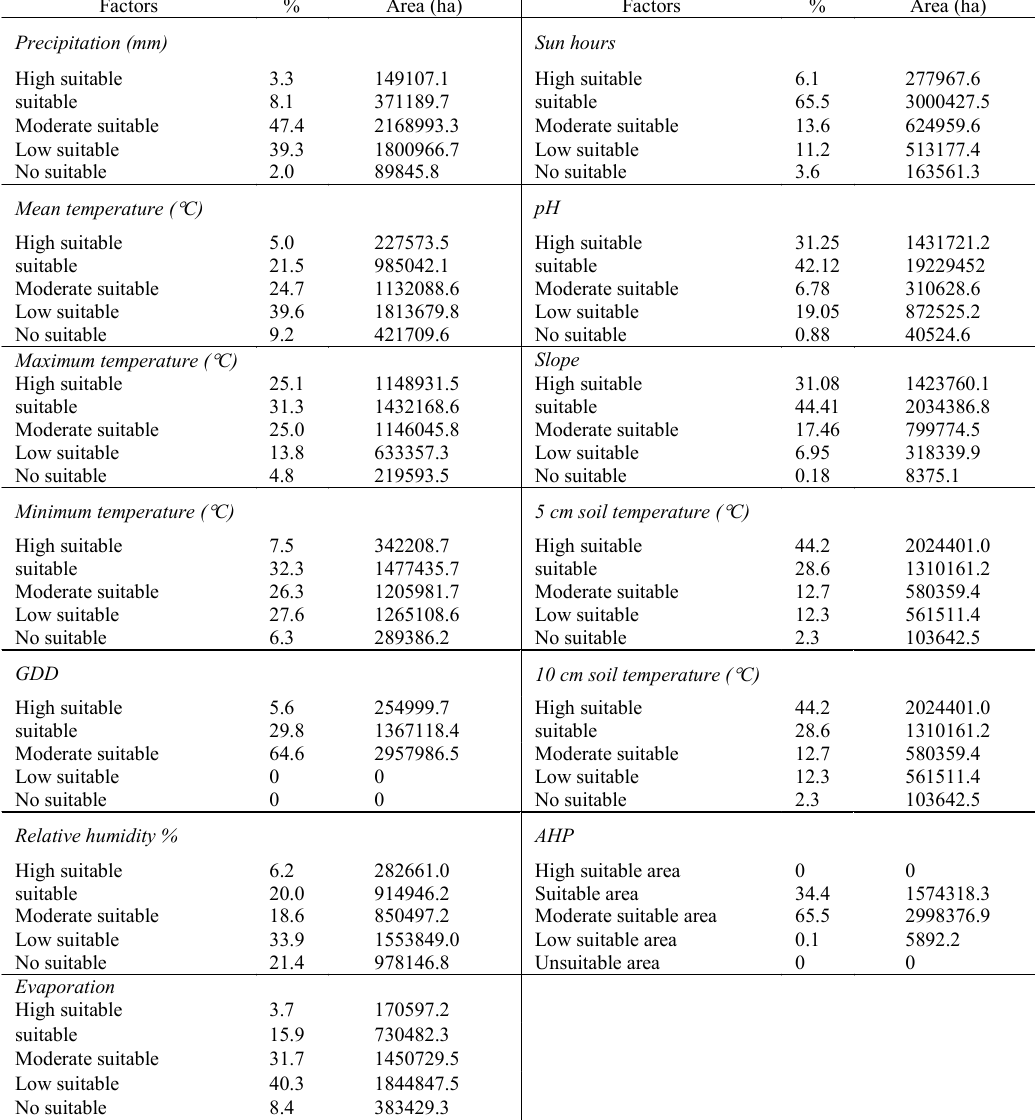
Table 5: Factors susceptibility percentages and covered